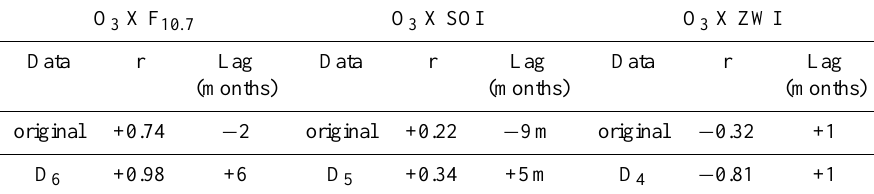
Table 1. Cross-correlation coefficients and lags (in months) between original and decomposed ozone data and ZWI, SOI and F 10 . 7 . O 3 X F 10 .